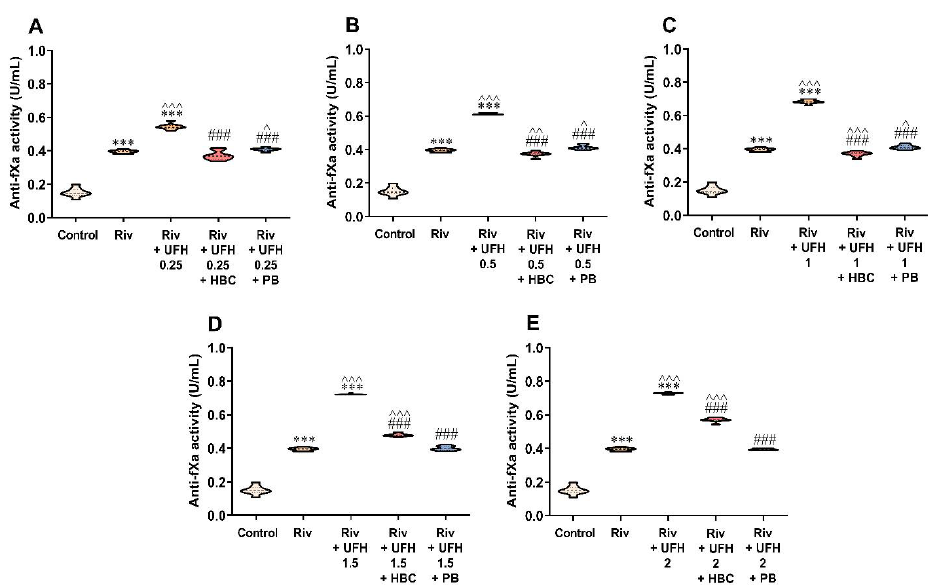
Figure 5. Inhibition of UFH at a concentration of 0.25 ( A ), 0.5 ( B ), 1 ( C ), 1.5 ( D ), and 2 U/mL ( E ) by HBC (10 µ g/mL) and polybrene (50 µ g/mL) during testing of rivaroxaban (50 ng/mL) anticoagulant activity by anti-factor Xa (anti-fXa) activity in human plasma. *** p < 0.001 vs. control; ˆ p < 0.05, ˆˆ p < 0.01, ˆˆˆ p < 0.001 vs. rivaroxaban; ### p < 0.001 vs. rivaroxaban with UFH, Mann–Whitney test. The results are shown as violin plots with minimum and maximum values and analyzed with GraphPad Prism 8 software. HBC, heparin-binding copolymer; PB, polybrene; Riv, rivaroxaban; UFH, unfractionated